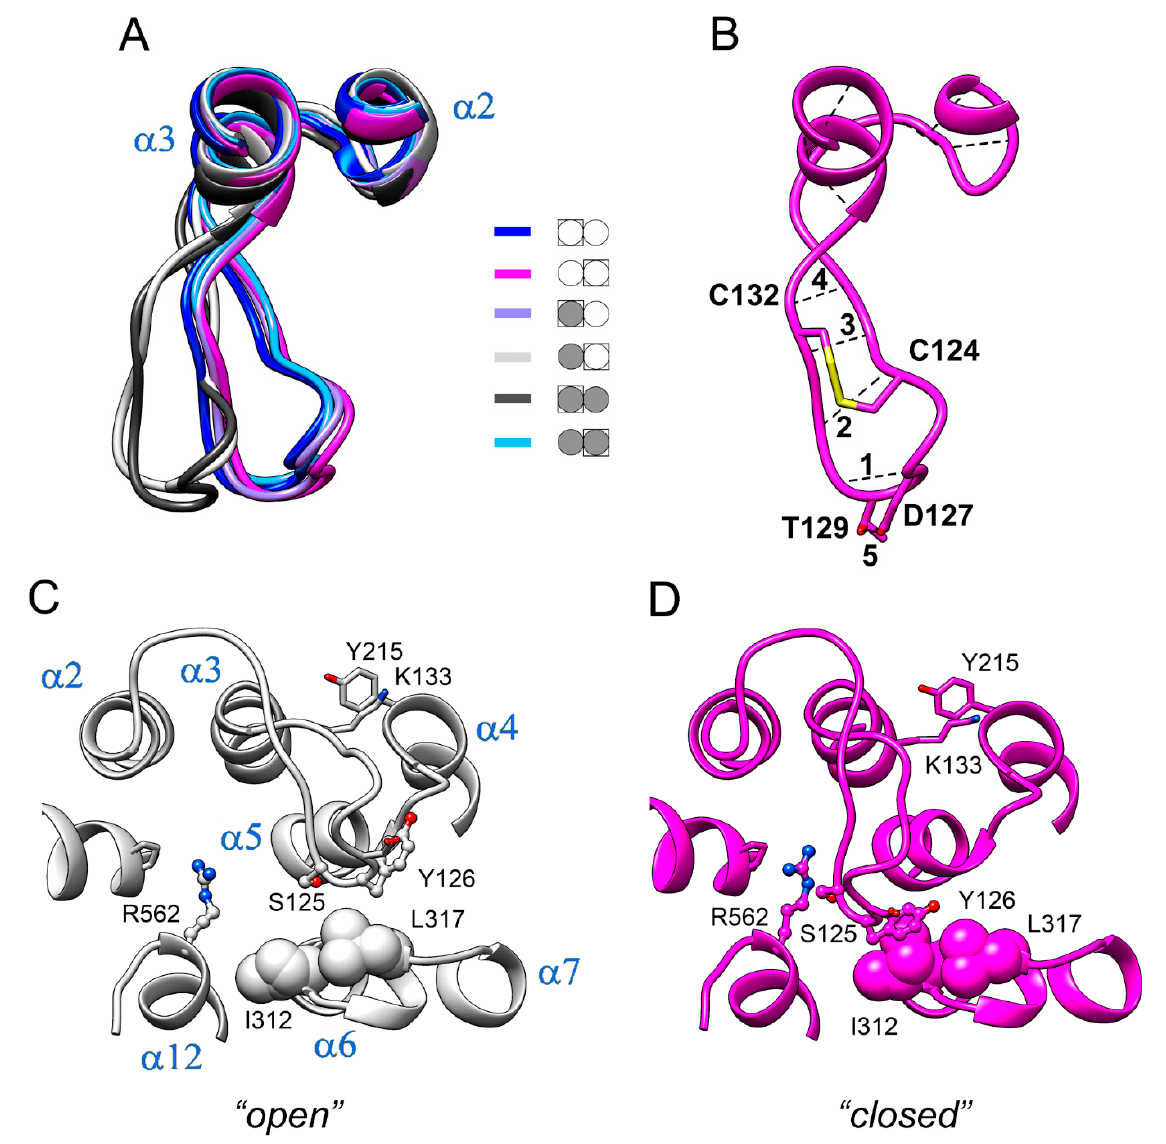
Figure 5. Two conformations of loop 2–3 observed in Vr-mPPase subunits. ( A ) The loop 2–3 part of the superposition of the six types of subunits found in Vr-mPPase dimers containing from zero to two bound IDP molecules. The color scheme shown defines dimer occupancy with IDP (closed circle) and the subunit selected for comparison (boxed). Molecule orientation is different from Figure 3A. ( B ) The intraloop H-bonds (dashed lines) and covalent S-S bond between two cysteine residues (thick yellow line). The H-bonds are numbered. ( C , D ) A more detailed view from the opposite side of the two conformations of loop 2–3 with nearby amino acid residues. A ball-and-stick or space-filling representation shows the sidechains of selected amino acid residues (marked with a one-letter code). α -Helices are labelled in panel C .